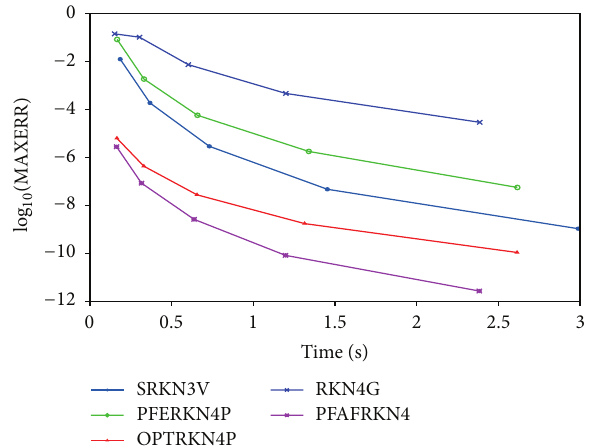
Figure 11: Efficiency curves for all methods for Problem 1 with 𝑒 = = 0.2 and ℎ = 1/2 𝑖 , 𝑖 = 3, ...,7 end